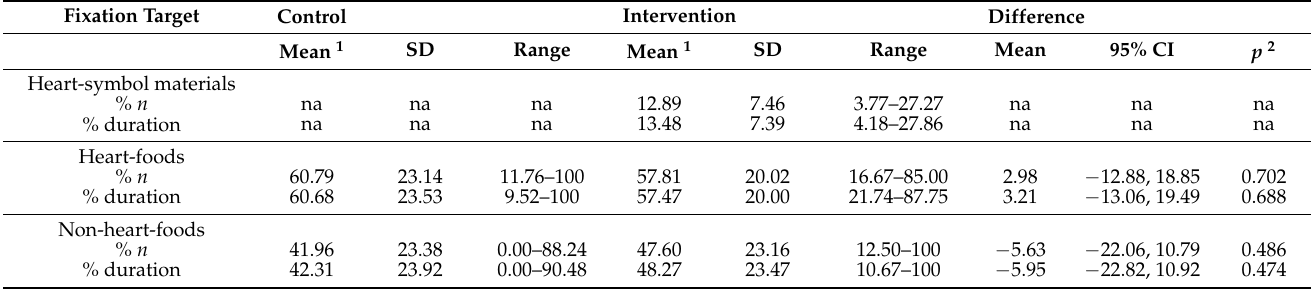
Table 3. The total number and total duration of fixations on Heart-symbol materials, heart-foods, and non-heart-foods as the percentages of total fixations on areas of interest before food choices at serving line stretch #2. Control n = 17, intervention n = 17.